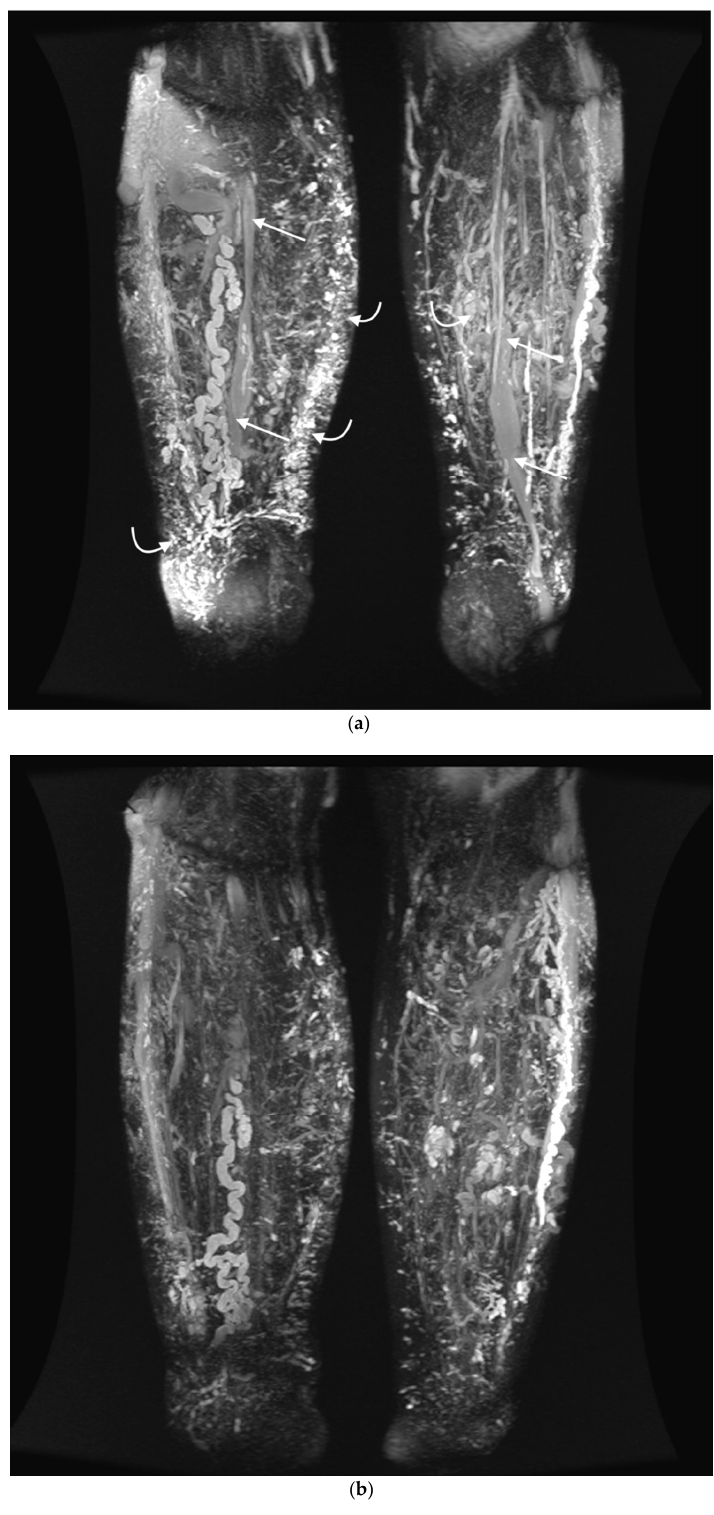
Figure 2. ( a ) MIP reconstruction from 3D T2-weighted FSE sequences (CUBE; GE Healthcare) in the coronal plane at the thigh before treatment. The occlusion of SSVs (straight arrows) with significantly fewer minor, abnormal veins in the subcutaneous tissue (bent arrows) after treatment is